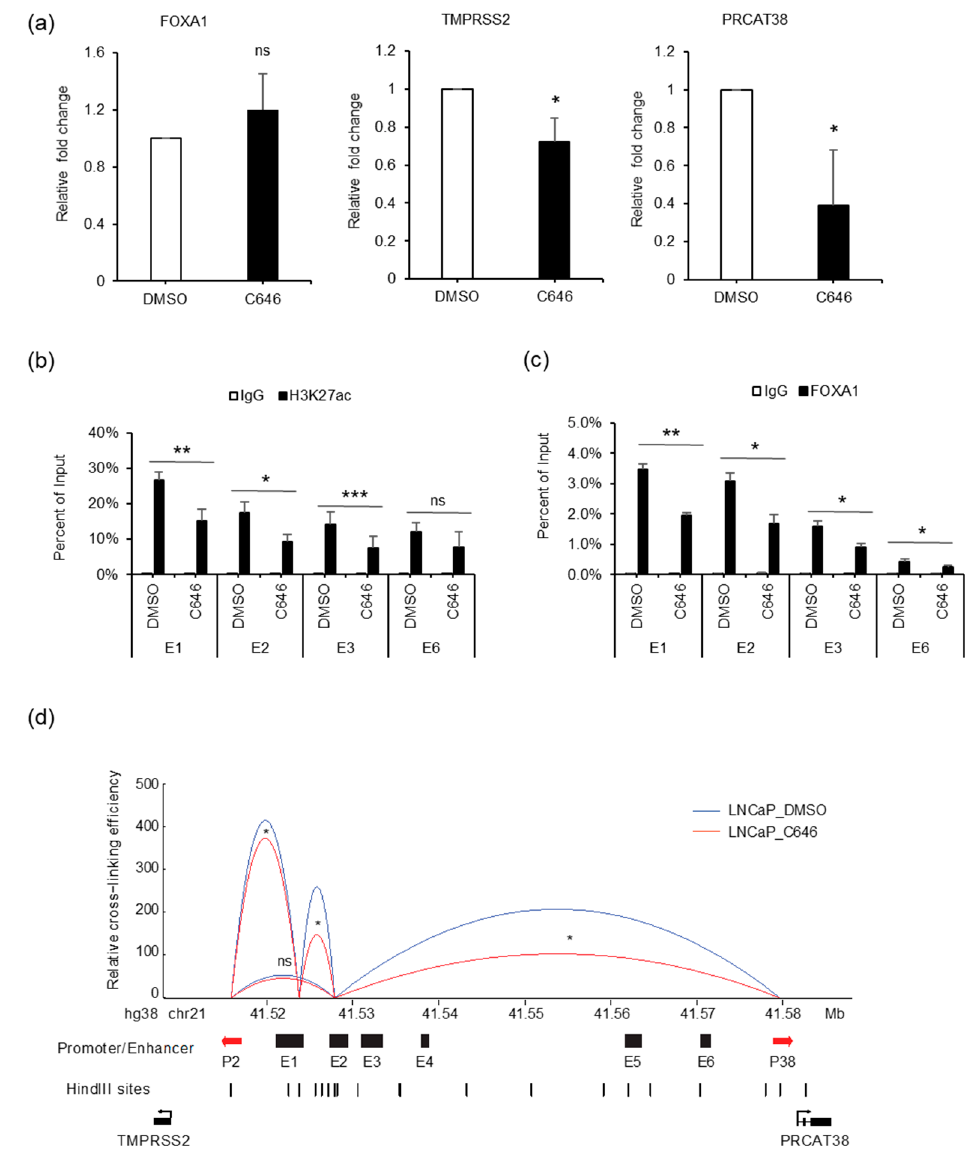
Figure 7. p300 inhibition impedes FOXA1 binding at the enhancers and chromatin looping between enhancers E1, E2 and the two promoters. ( a ) qPCR showing the change in expression of FOXA1 , TMPRSS2 and PRCAT38 before and after C646 treatment in LNCaP. ( b – c ) ChIP-qPCR in LNCaP cells before and after C646 treatment showing H3K27ac and FOXA1 enrichment over the enhancer regions. Data are shown as the mean ± SD (n = 3). ( d ) 3C-qPCR analysis of the looping between enhancers and promoters before and after C646 treatment in LNCaP (peak values of the loops are the mean of 3 biological replicates). *: P < 0.05, **: P < 0.01, ns: not